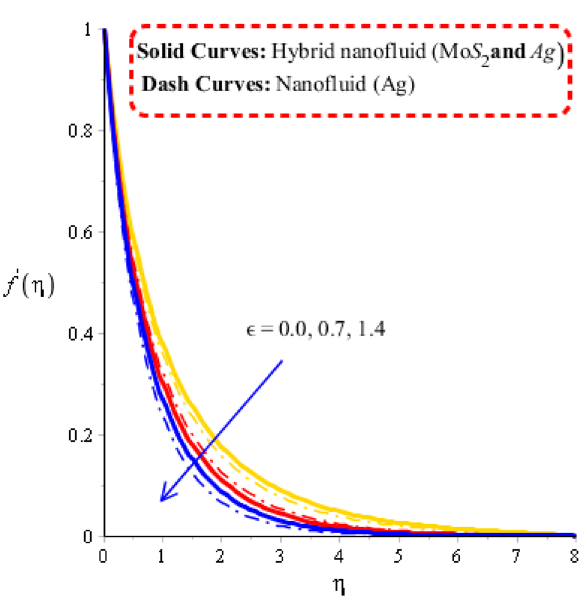
Figure 2. Velocity curves against Fr when ε δ = 2.0, ϕ 1 = 0.003, ϕ 1 = 0.0075.